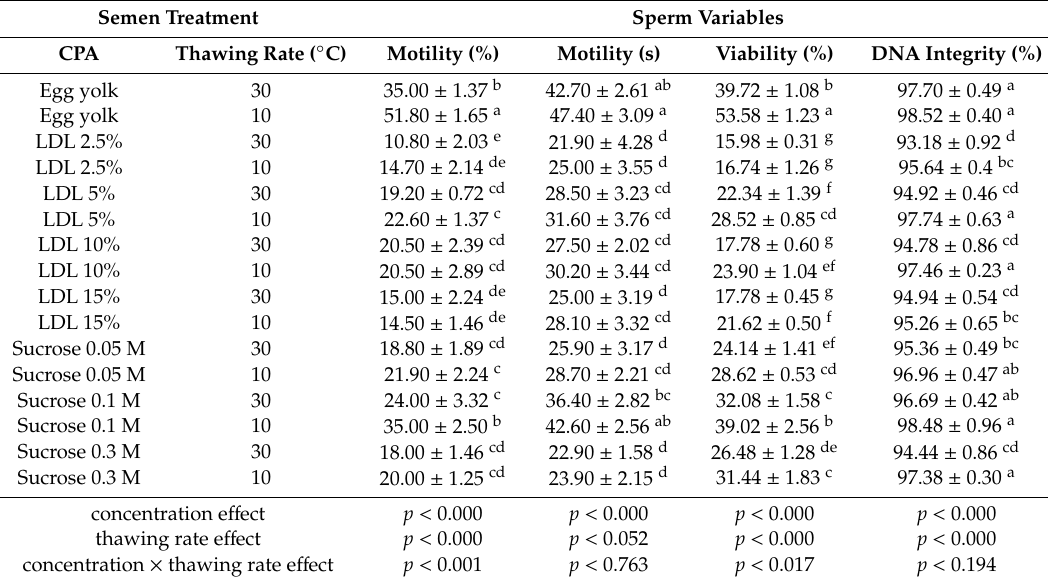
Table1. Spermqualityvariables(mean ±